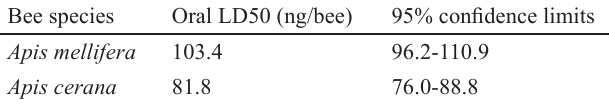
Table 1. The LD50 values and its 95% confidence limits of chlorpyrifos at 24 h in Apis mellifera and Apis cerana